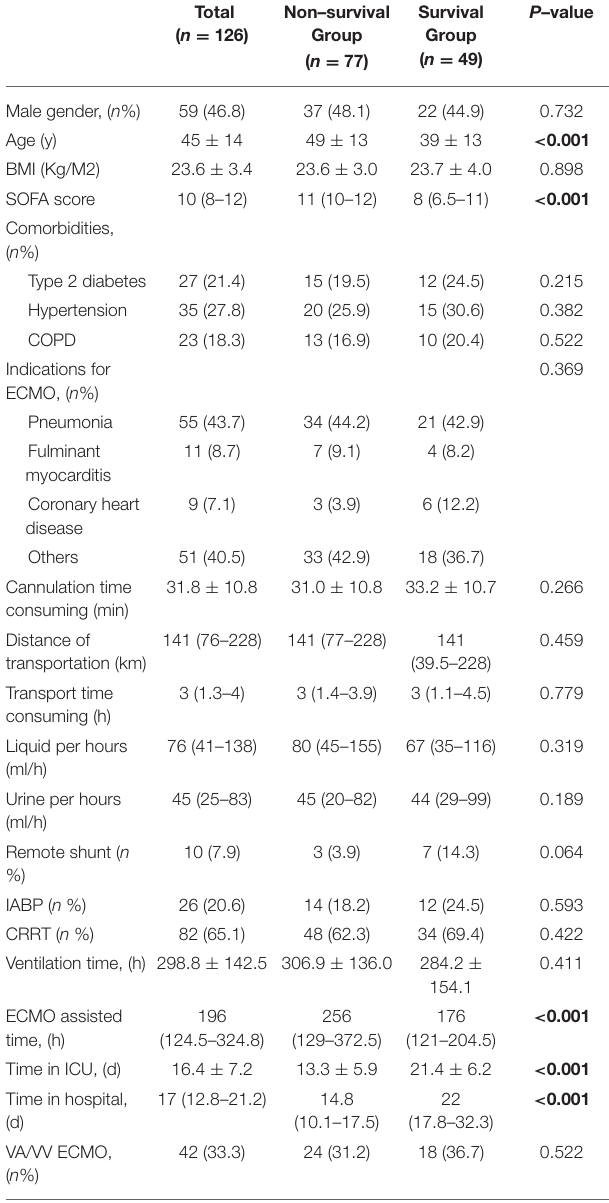
TABLE 1 | Baseline characteristics of transferred ECMO